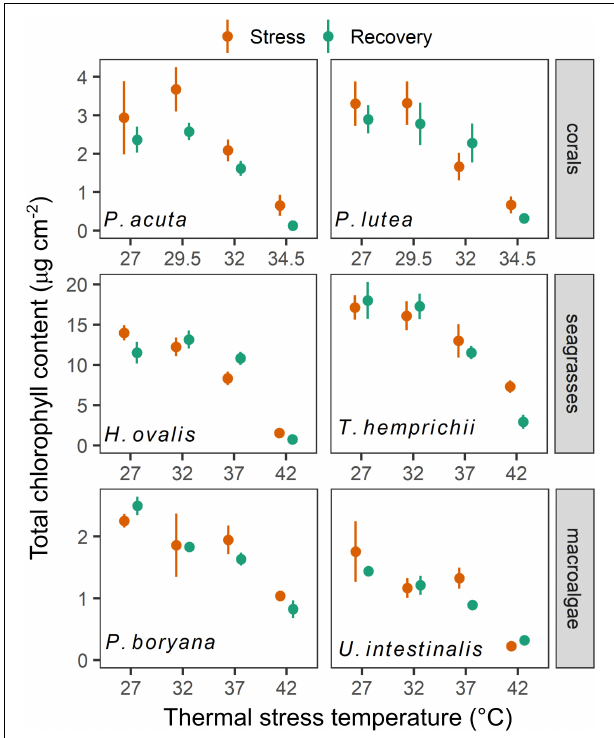
FIGURE 4 | The effects of experimental temperatures on total chlorophyll content of corals, seagrasses and macroalgae at the end of stress and recovery periods. Values are shown as mean ± SE ( n = 3). For each replicate, 3 individuals were sampled. Corals were subjected to 27–34.5 ◦ C in stress period and 27 ◦ C in recovery period. Seagrasses and macroalgae were subjected to 27–42 ◦ C in stress period and 32 ◦ C in recovery period.